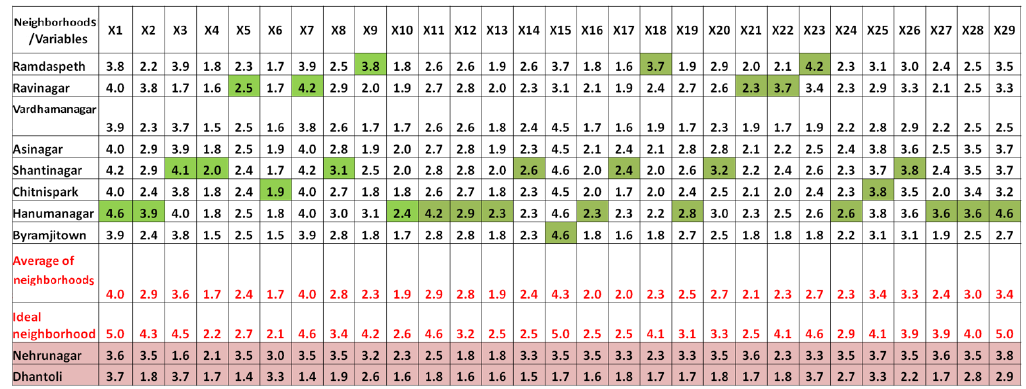
Figure 17. Average Scores of variables plotted against the respective